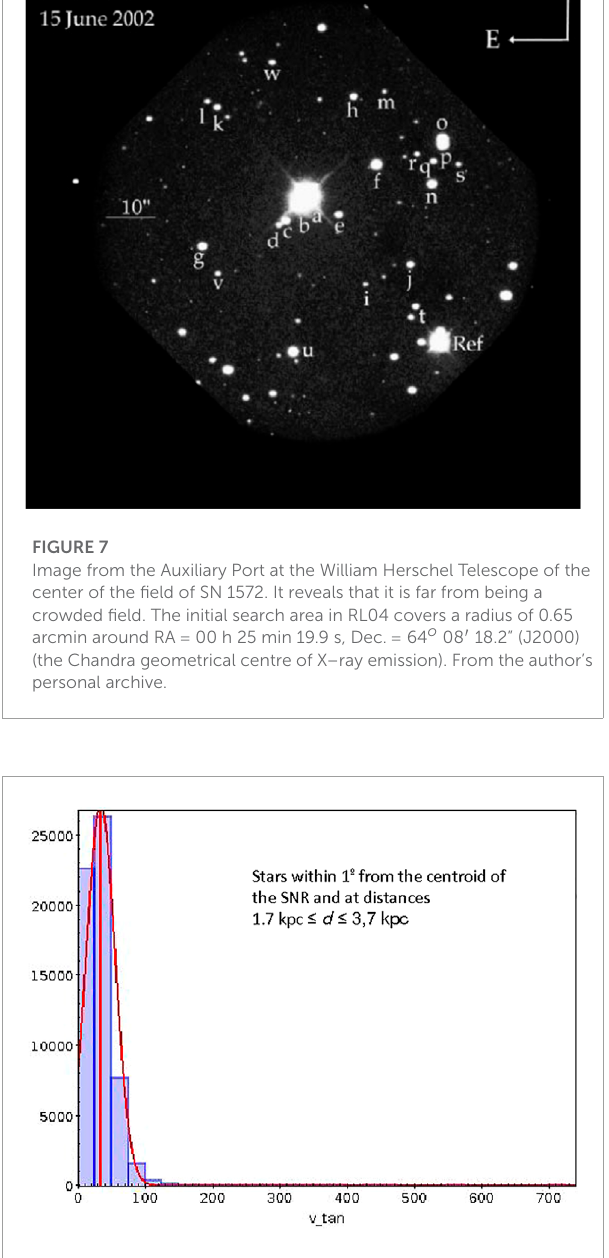
higher than the rest is Tycho G. The peculiarity of a star, Tycho G, comes from three facts: a larger proper motion mostly in declination than the other stars, a larger eccentricity and larger radial velocity in the LSR V (other star, Tycho U, has a similar proper motion in R declination than Tycho G, but no eccentricity and a small V